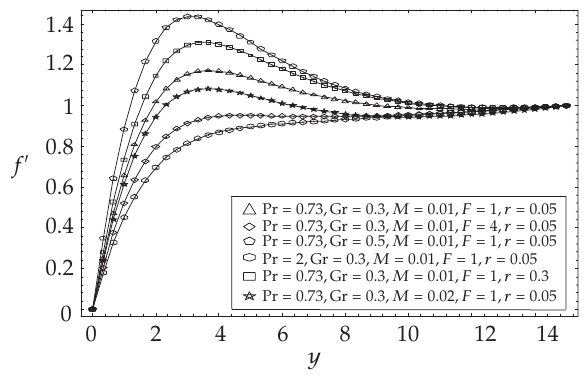
Figure 3.1 . Variation of the dimensionless velocity component f (cid:6) with Pr , Gr ,M,r , and F parameters.